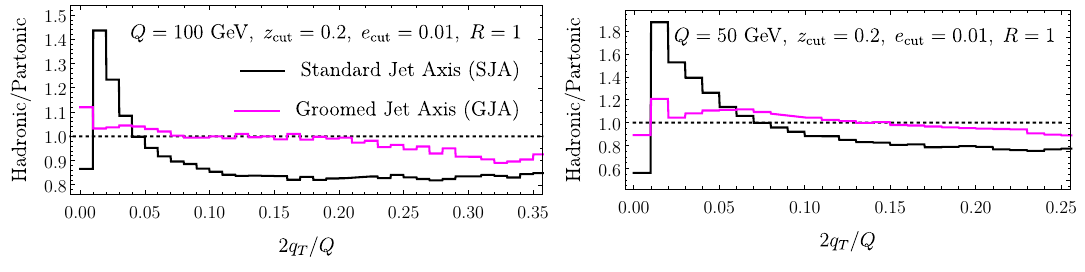
Figure 1 . Hadronization effects in a typical e + e mass values, Left : Q = 100 GeV, Right : Q = 50